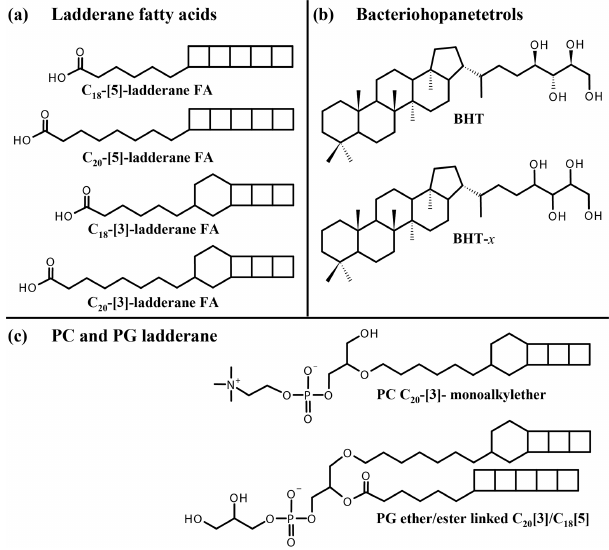
Figure 1. Structures of lipid biomarkers used in this study: (a) lad- derane fatty acids (FAs) with 5 or 3 cyclobutane moieties and 18 or 20 carbon atoms. (b) Bacteriohopane-17 β , 21 β (H), 22R, 32R, 33R, 34S, 35-tetrol (BHT), ubiquitously synthesized by bacteria, and bacteriohopanetetrol stereoisomer (BHT- x ), with an unknown stere- ochemistry of the tetrafunctionalized side chain, uniquely synthe- sized by marine anammox bacteria. (c) Ladderane intact polar lipids PC C 20 -[3]-monoalkylether (“PC ladderane”) and PG ether/ester linked C 20 [3] / C 18 [5] (“PG